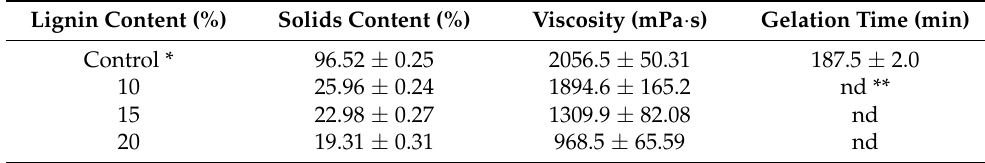
Table 4. Basic properties of PVOH–lignin–hexamine-based adhesives. Lignin Content (%) Solids Content (%)